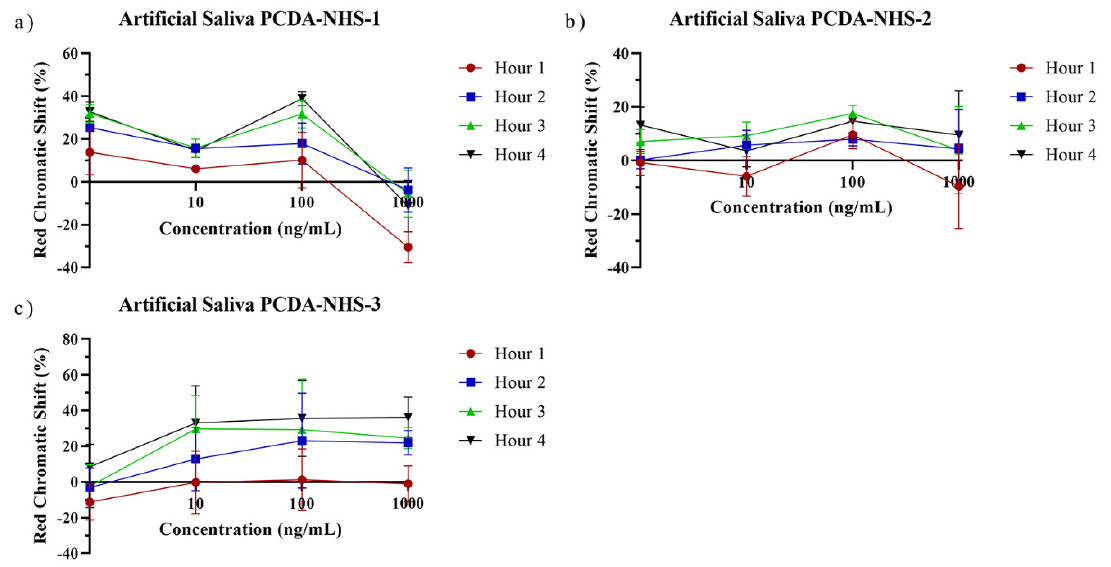
Figure 8. Hourly red chromatic shift for artificial saliva samples. RCS data obtained from sensors of PCDA-NHS-1 ( a ), PCDA-NHS-2 ( b ), and PCDA-NHS-3 ( c ), groups exposed to 1, 10, 100, and 1000 ng/mL of SARS-CoV-2 spike protein in artificial saliva. As time increased, RCS tended to increase for sensors at each concentration.